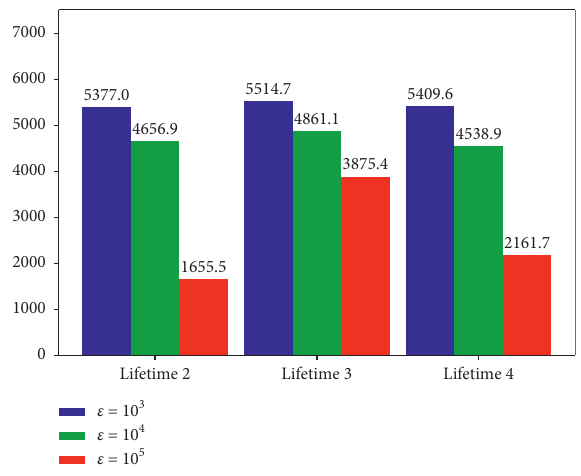
Figure 6: MEP for ε